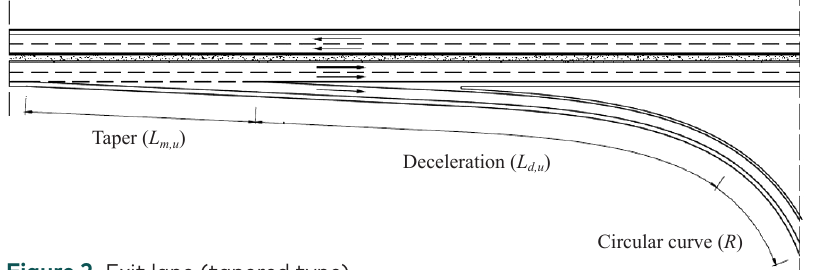
Figure 2. Exit lane (tapered